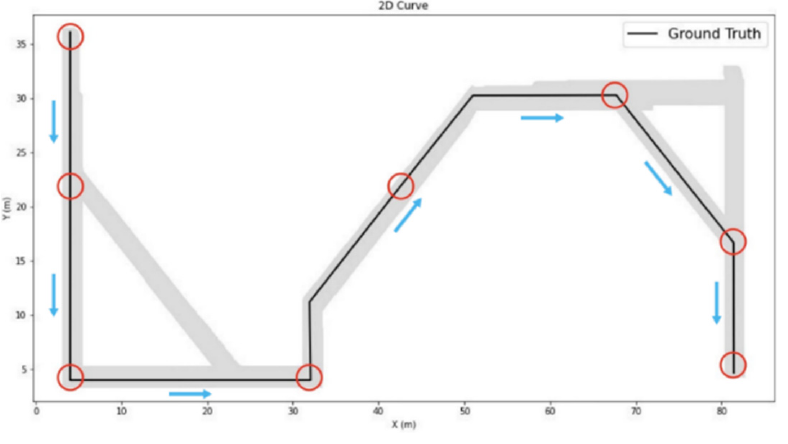
Figure 10. Experimental route.